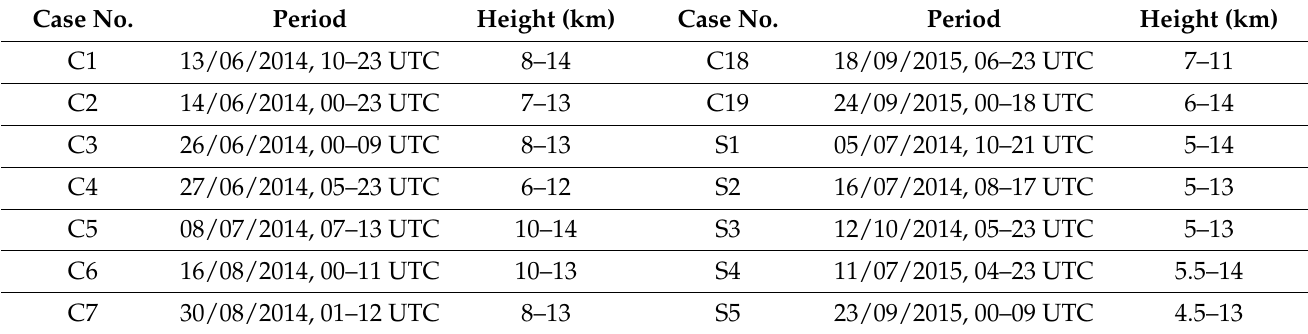
Table 2. Events of three types of ice clouds (C: cirrus, S: stratiform, and A: anvil) and their height ranges.